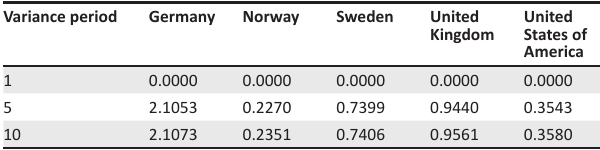
TABLE 9: Variance decomposition of South Africa. Variance